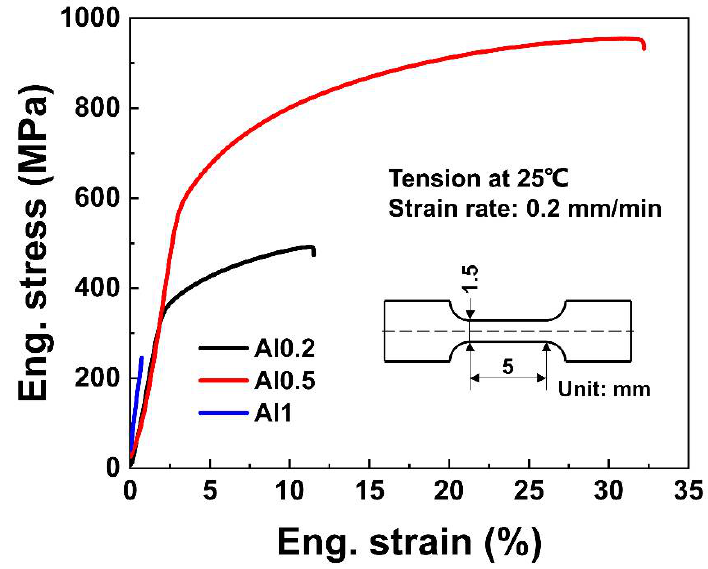
Figure 5. Tensile engineering stress–strain curves of AlxCoCrFeNi HEAs at room temperature. (The gauge length is 5 mm, while the width and thickness are 1.5 mm and 1 mm, respectively. The strain rate is 0.2 mm/min). Table 2. Mechanical properties of Al x CoCrFeNi HEAs.